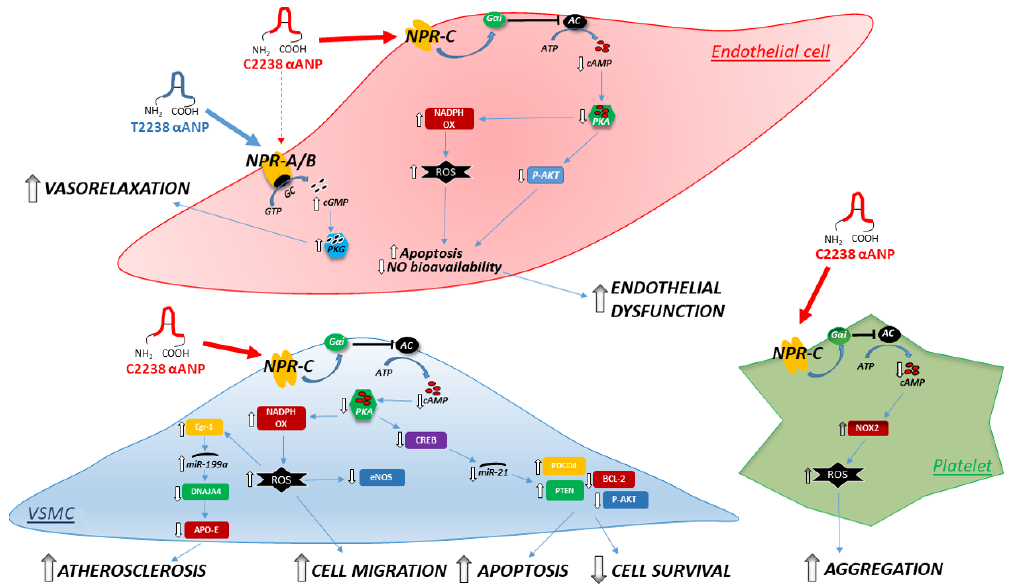
Figure 1. Schematic representation of the molecular signaling pathways underlying the effects of CC2238/ α ANP in endothelial cells, smooth muscle cells, and platelets. Abbreviations: AC, adenylate cyclase; Akt, protein kinase B; APO-E, apolipoprotein E; ATP, adenosine triphosphate; BCL-2, B-cell lymphoma 2; cAMP, cyclic adenosine monophosphate; cGMP, cyclic guanosine monophosphate; CREB, cAMP response element-binding protein; DNAJA4, DnaJ (Hsp40) homolog; Egr-1, early growth response protein-1; eNOS, endothelial nitric oxide synthase; GC, guanylate cyclase; GTP, guanosine triphosphate; G α i, inhibitory G protein; miR-21, microRNA-21; miR-199, microRNA-199; NADPH OX, nicotinamide adenine dinucleotide phosphate-oxidase; NO, nitric oxide; NOX2, NADPH oxidase 2; NPR-A/B, natriuretic peptide type A/B receptors; NPR-C, natriuretic peptide type C receptor; P-AKT, phosphoprotein kinase B; PDCD4, programmed cell death protein 4; PKA, protein kinase A; PKG, protein kinase G; PTEN, phosphatase and tensin homolog; ROS, reactive oxygen species; VSMCs, vascular smooth muscle cells; α ANP, carboxy-terminal atrial natriuretic peptide, wild-type (T2238) and mutant (C2238). Arrows indicate the positive stimulation within each pathway. The dotted arrow indicates lower affinity binding of C2238 for NPRA/B.